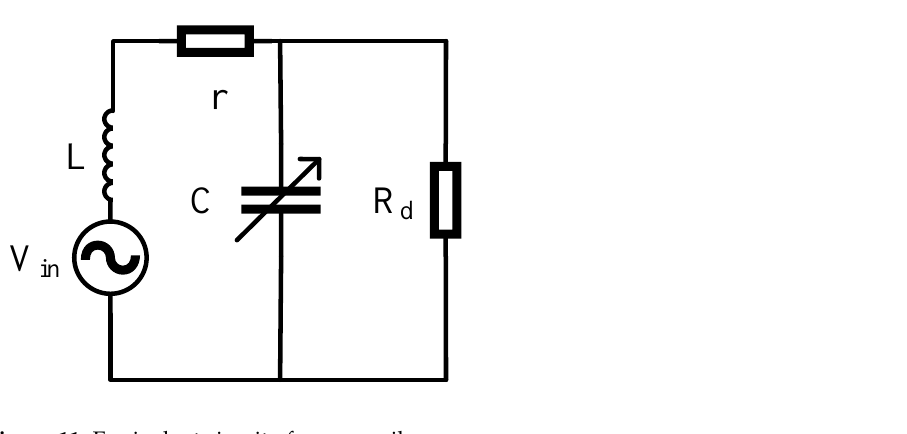
Figure 10. Block diagram of analog circuit.